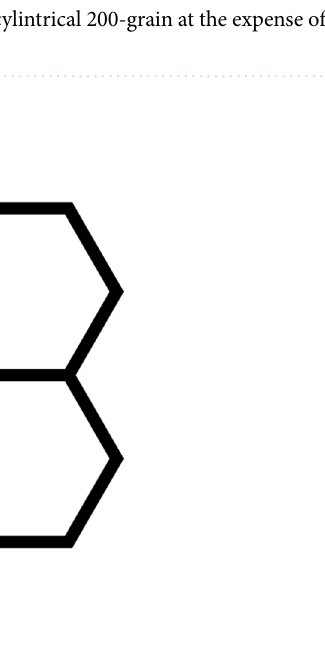
Figure 6. Idealized plan-view of the columnar structure of the nanotwinned grains (black thick lines—are the triple junctions which are good leaving/parking places for atoms crossing the interface with the